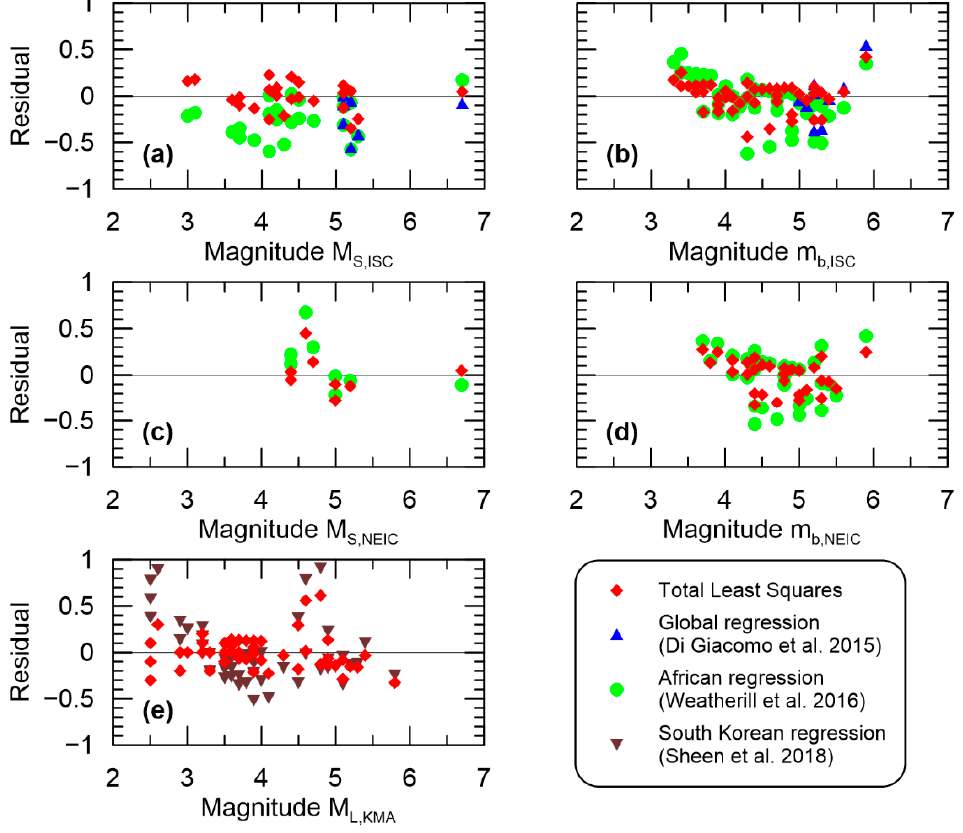
Figure 10. Comparing residuals between proposed regressions and those from previous studies for ( a ) M S,ISC , ( b ) m b,ISC , ( c ) M S,NEIC , ( d ) m b,NEIC , and ( e ) M L,KMA .